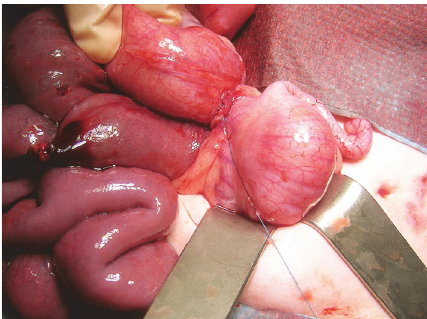
Figure 12: Acute small bowel obstruction in a girl aged 20 months. Bowel obstruction was caused by a loose guide thread and fibrous band crossing the terminal ileum. This complication occurred 18 months after RJFT insertion and was managed by resection of the fibrous band and guide thread (patient 7).